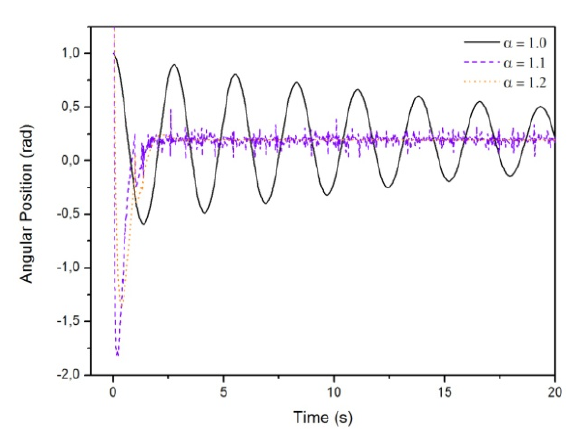
Figure 13. Time history (values of α ≥ 1).